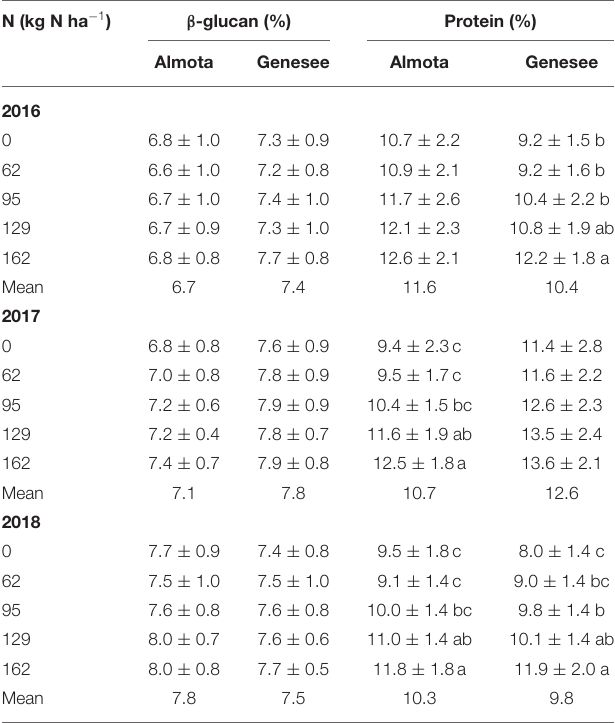
TABLE 3 | Mean data across six site-years for varietal differences in β -glucan and protein.